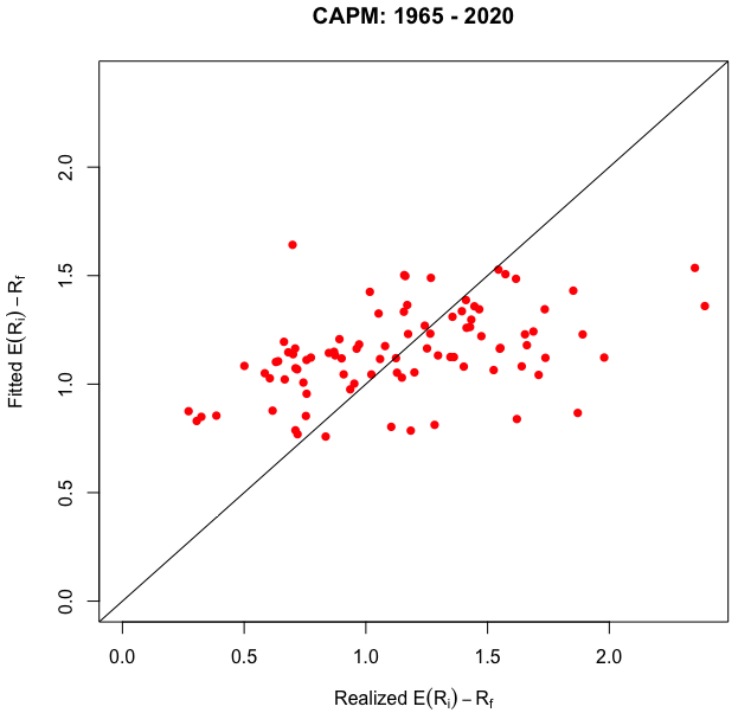
Figure 7. Out-of-sample cross-sectional relationships for the CAPM between average one-month- ahead fitted (predicted) excess returns in percent ( y -axis) and average one-month-ahead realized excess returns in percent ( x -axis): January 1965 to December